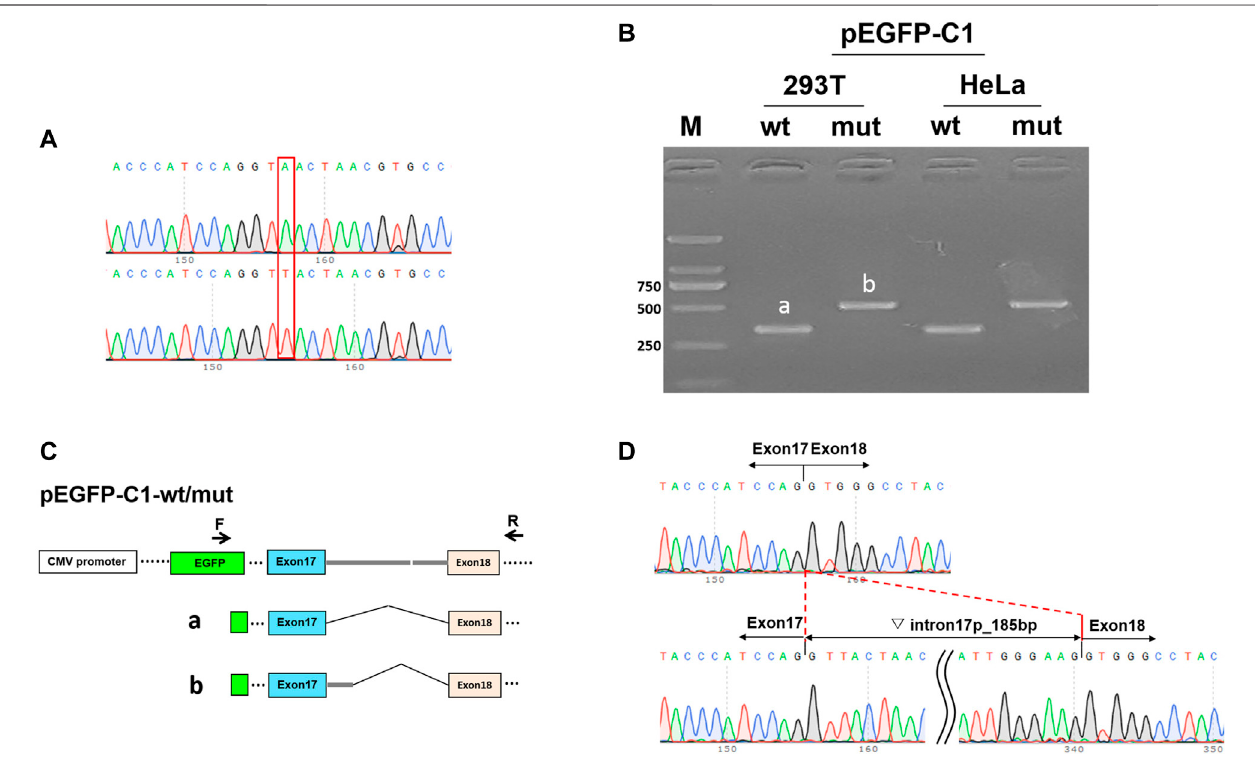
FIGURE 2 | Minigene splicing assay in HEK293T and HeLa cells. (A) Sequences of the vector pEGFP-C1. Up: wild-type (wt), down: mutant (mut). (B) Image representing the results of gel electrophoresis shows the ampli fi ed transcript during RT-PCR corresponding to cDNAs isolated from HEK293T and HeLa cells. a: wt, b: mut. (C) pEGFP-C1-wt/mut construction and schematic diagram of the splice. (D) Sequence at the site of mutation in pEGFP-C1-MYO5B-wt (up) and pEGFP-C1- MYO5B-mut